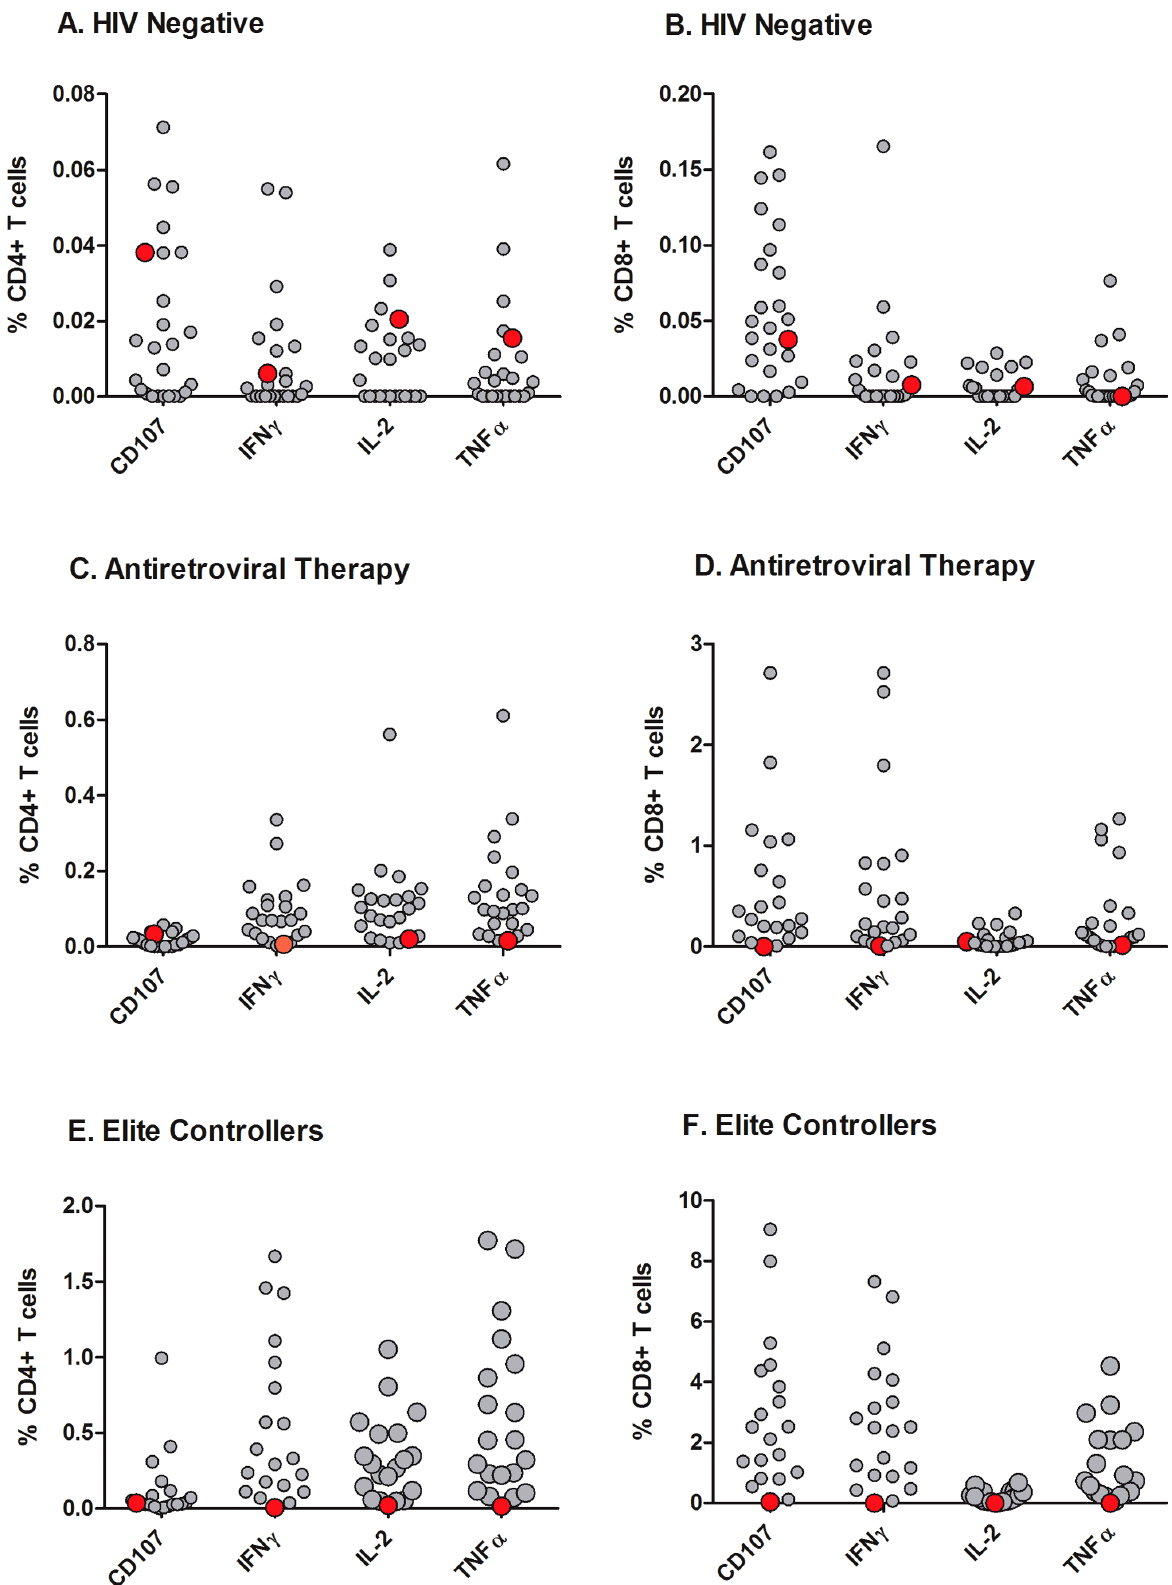
Figure 4. HIV Gag-specific cell mediated immune responses. PBMC were obtained from the Berlin Patient (solid red circles), HIV-uninfected adults (open black circles in 4A–B), chronically HIV-infected adults on long term ART with undetectable plasma viral loads (open black circles, 4C–D), and elite controllers (open black circles, 4E–F). PBMC were stimulated with CMV pp65 or HIV Gag peptide pools, and flow cytometry was used to